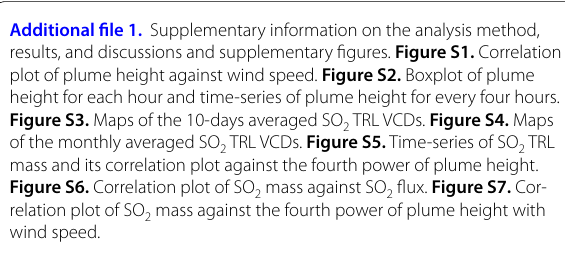
Figure S3. Maps of the 10-days averaged SO 2 TRL VCDs. Figure S4. Maps of the monthly averaged SO 2 TRL VCDs. Figure S5. Time-series of SO 2 TRL mass and its correlation plot against the fourth power of plume height. Figure S6. Correlation plot of SO 2 mass against SO 2 flux. Figure S7. Cor- relation plot of SO 2 mass against the fourth power of plume height with wind